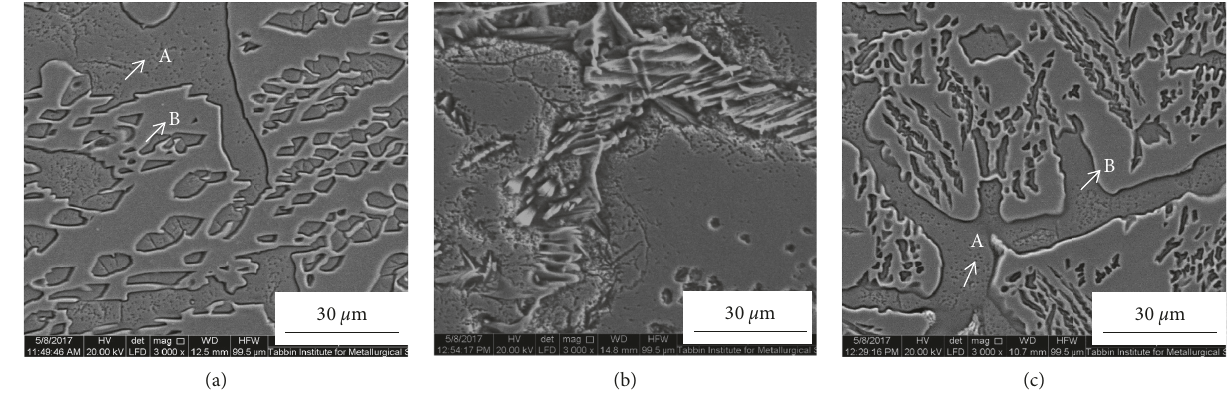
Figure 3: Scanning electron micrographs of the as-cast samples (a) 0.0 and (b) 3.0wt.% Ti at 30mm and (c) 0.0wt.% Ti sample at